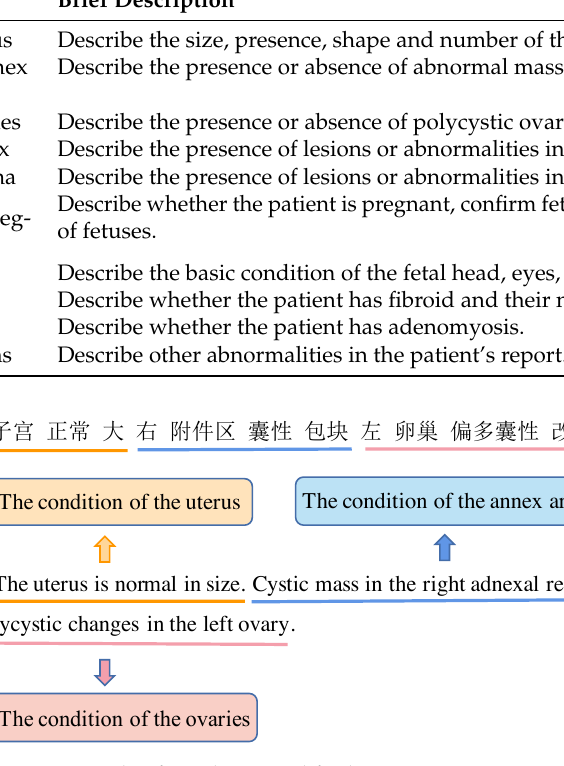
Figure 6. Example of an ultrasound